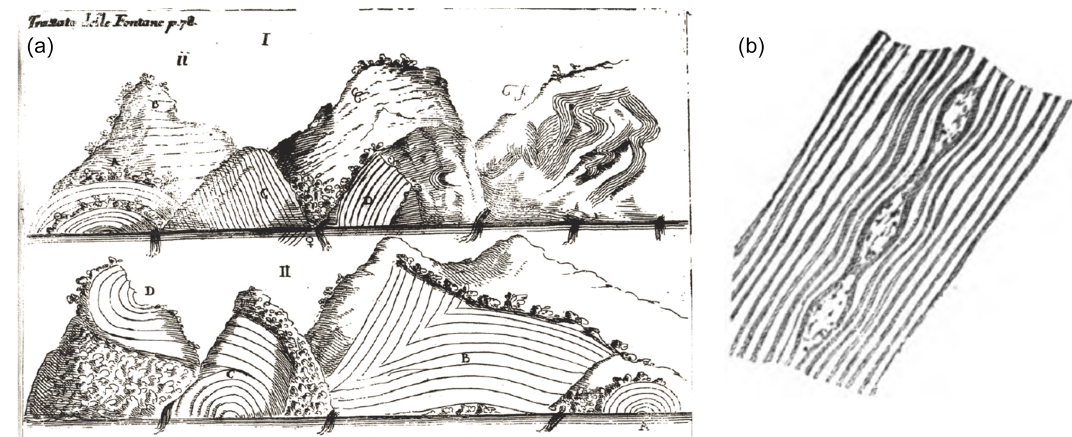
Figure 3. (a) Fold observations in the European Alps around the Lake Uri in Switzerland. The panel shows a part of a larger sketch of Johann Scheuchzer, which was published by Antonio Vallisneri (1715; see Luzzini, 2011; Vaccari, 2004). (b) Sketch of necking (pinch-and-swell structure) from Ramsay